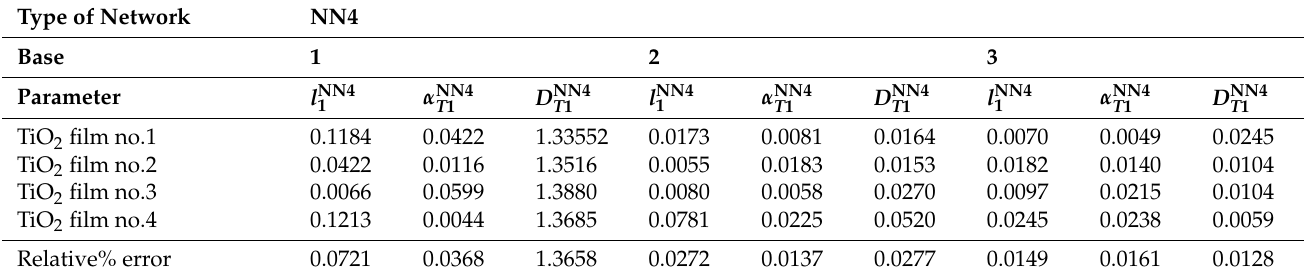
Table 5. Relative (%) prediction error of TiO 2 thin-film parameters by NN4 for 4 signals “out of step”.